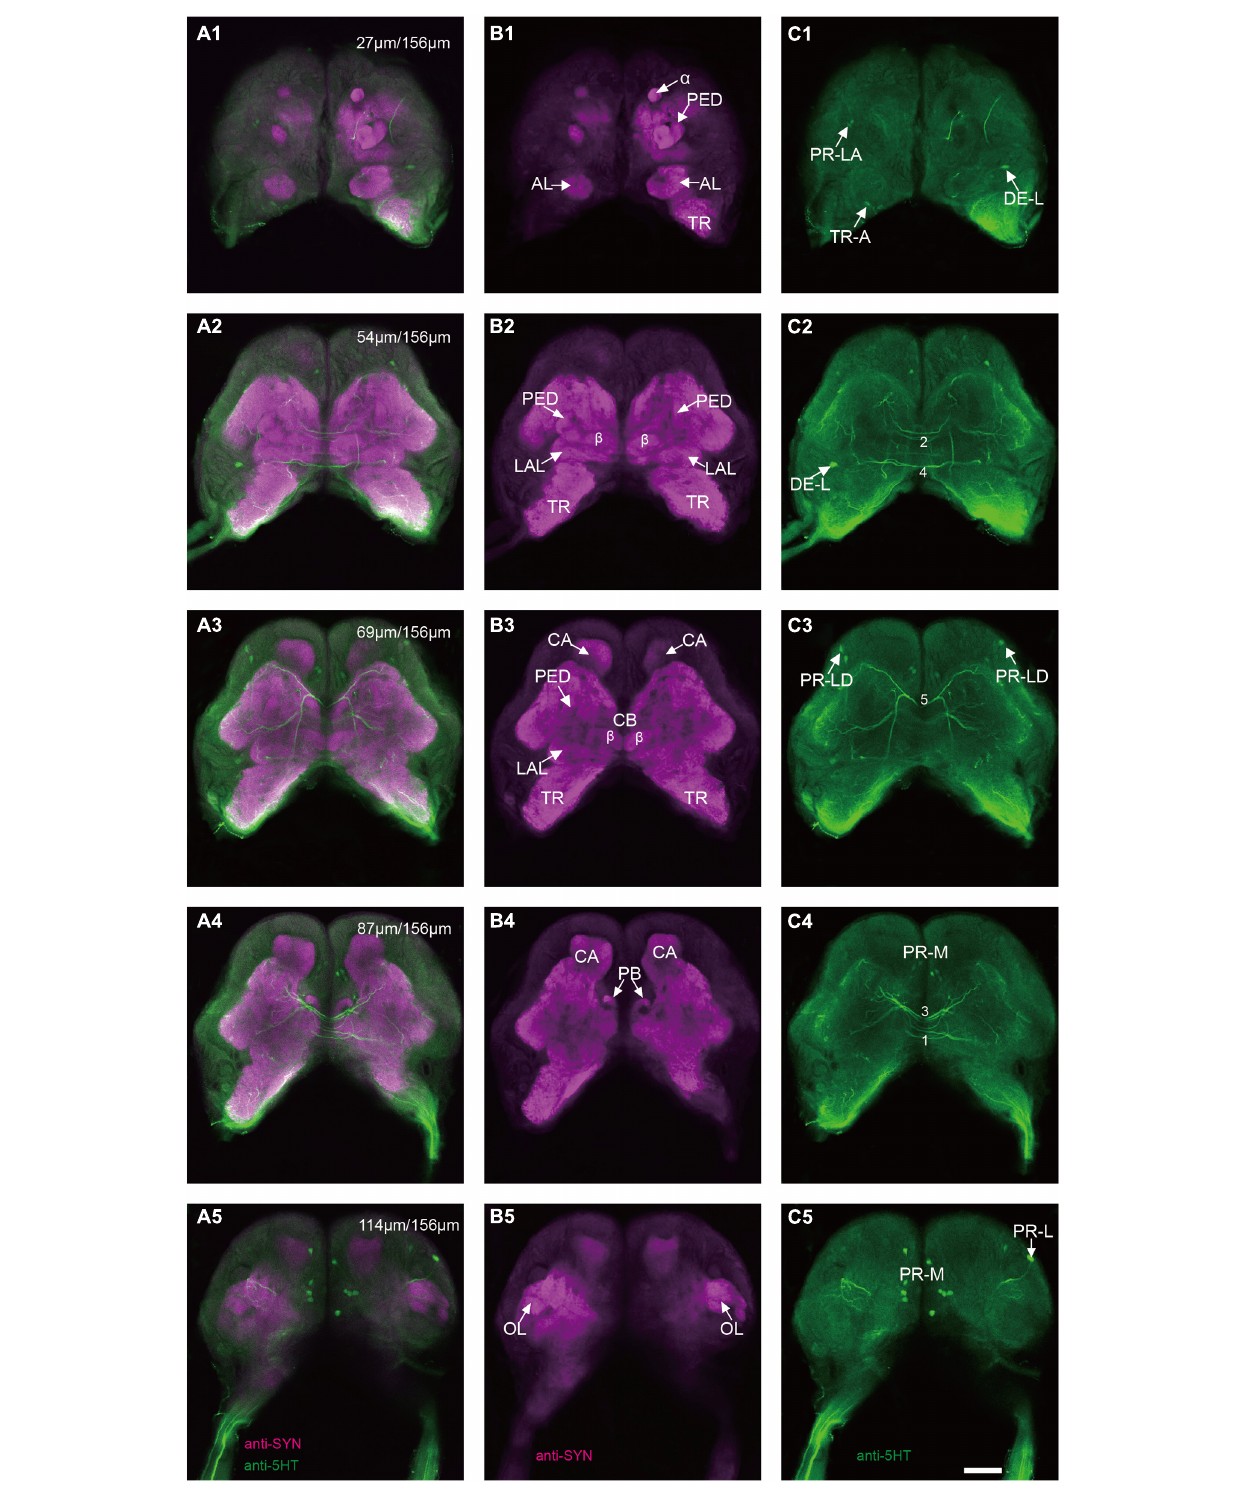
FIGURE 1 | Confocal images of the brain of Spodoptera frugiperda larvae. (A1–A5) Merged confocal image showing the neuropil (magenta) and the serotonin-immunoreactive neurons (green). (B1–B5) Confocal image showing the neuropils of the brain. (C1–C5) Confocal image showing the serotonin-immunoreactive neurons in the brain. α , alpha lobe; AL, antennal lobe; CA, calyx; CB, central body; LAL, lateral accessory lobe; OL, optic lobe; PB,: protocerebral bridge; PED, pedunculus; TR, tritocerebrum. Scale bars, 100 µ m.